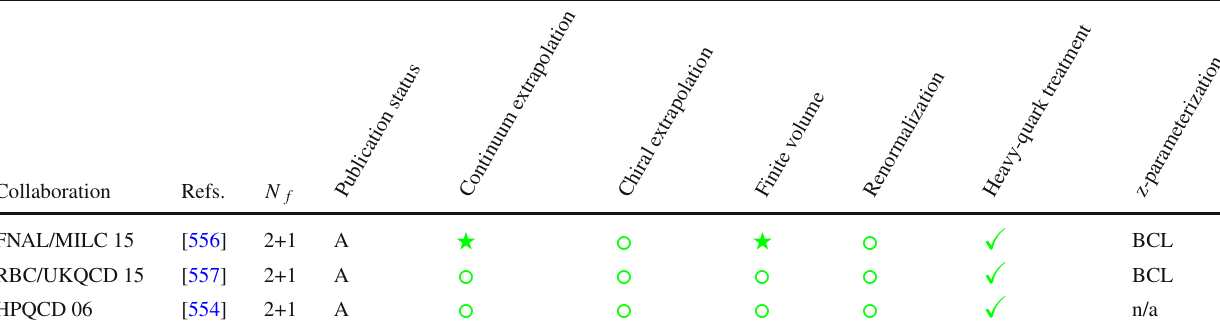
Table 45 Results for the B → π(cid:6)ν semileptonic form